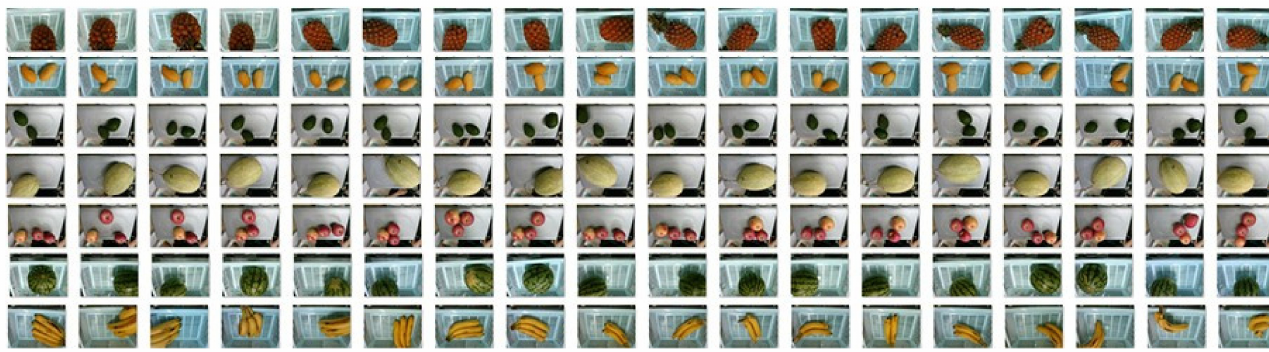
Figure 5. The sample data of the database. The database of this paper could be obtained through the website: https: //github.com/ClaireFan421/dataset-fruit029.git (accessed on 29 October 2020).